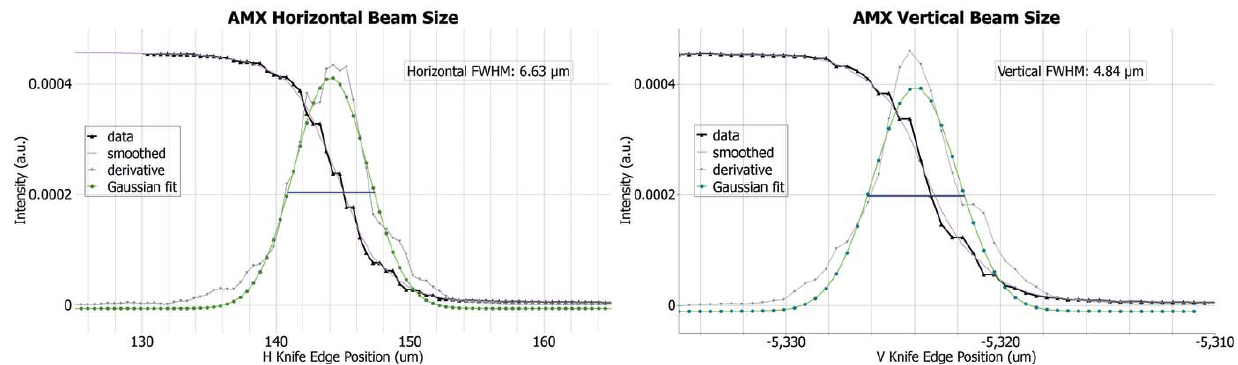
Figure 2 AMX beam profile obtained during the hot commissioning of the beamline (2016). AMX beam spot at focus as detected by a tungsten knife-edge scan in the horizontal and vertical directions. Left: horizontal profile with a 6.6 m m FWHM. Right: vertical profile with a 4.8 m m FWHM.